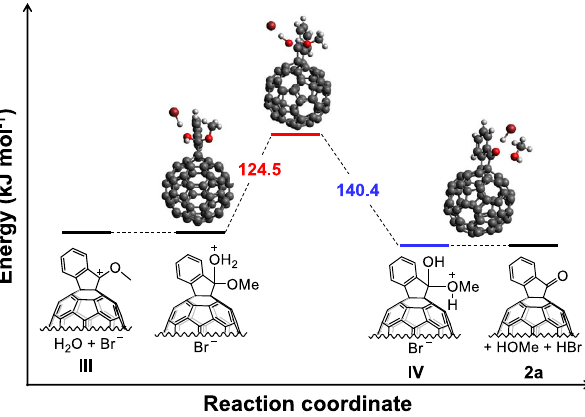
Fig. 6 DFT calculations. DFT calculation for the key step from intermediate III to 2a in the presence of Br – .